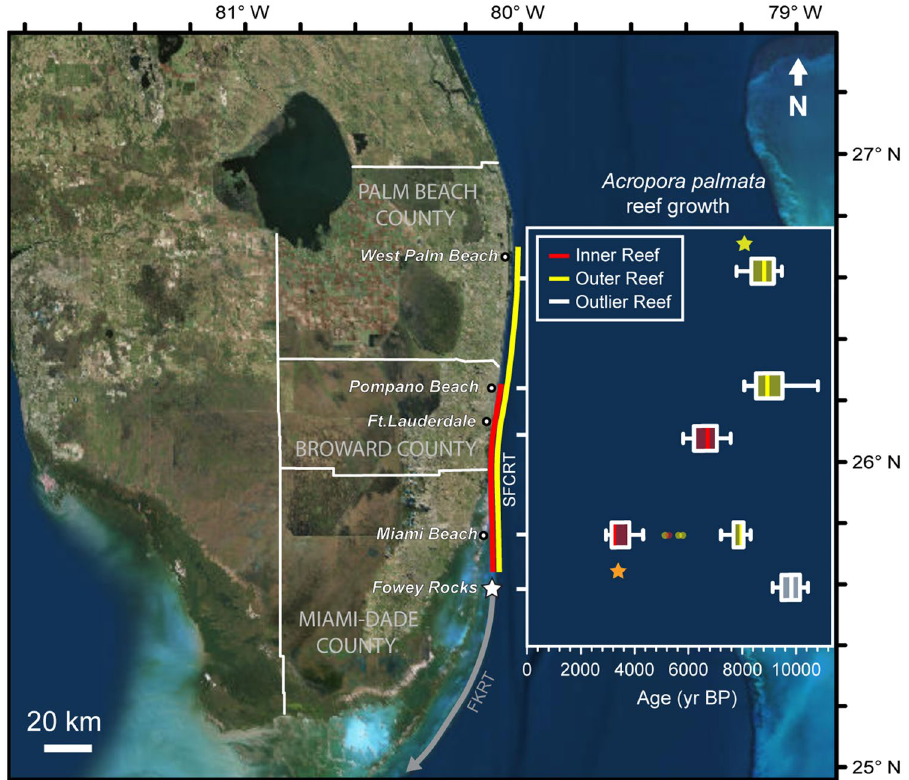
represent the medians (solid verticals) and interquartile ranges (boxes) of radiometric ages of A. palmata from each location. Error bars (whiskers) are 1.5 × the interquartile range. Points indicate data outside this